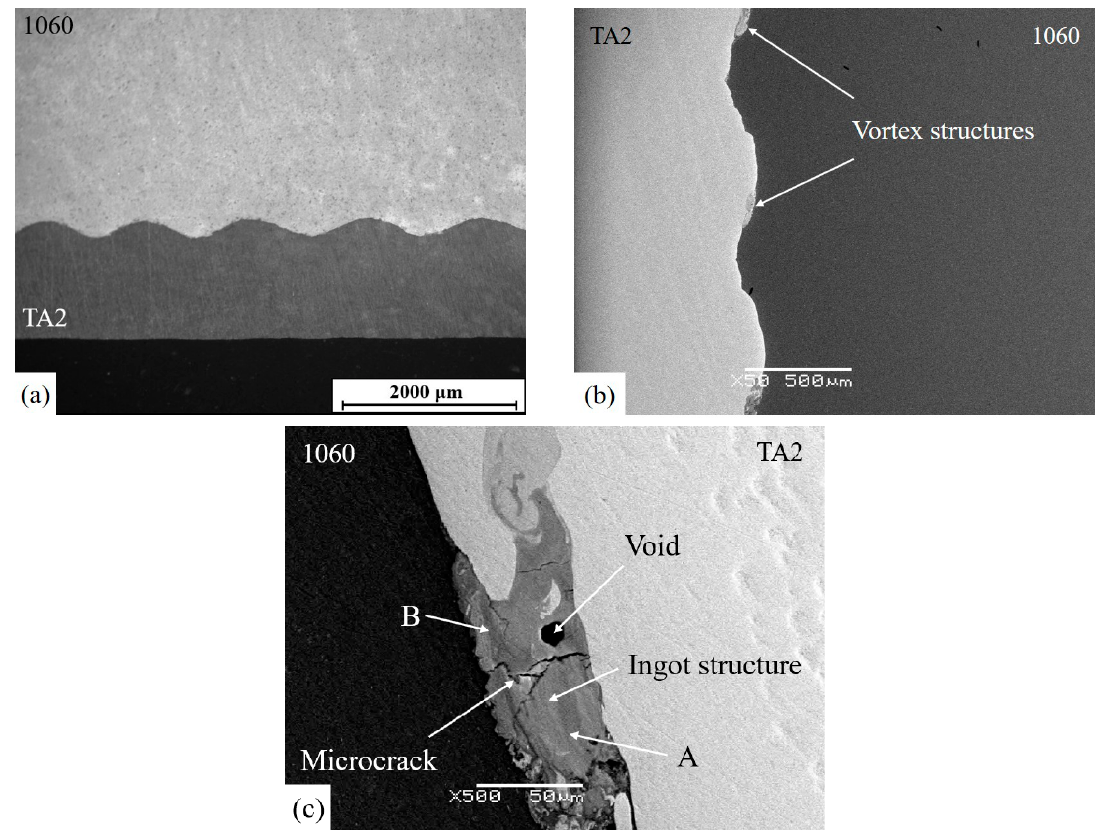
Figure 3. Microstructure of the bonding interface of sample 1: ( a ) small wave bonding interface; ( b ) vortex structures; ( c ) Ingot structure.